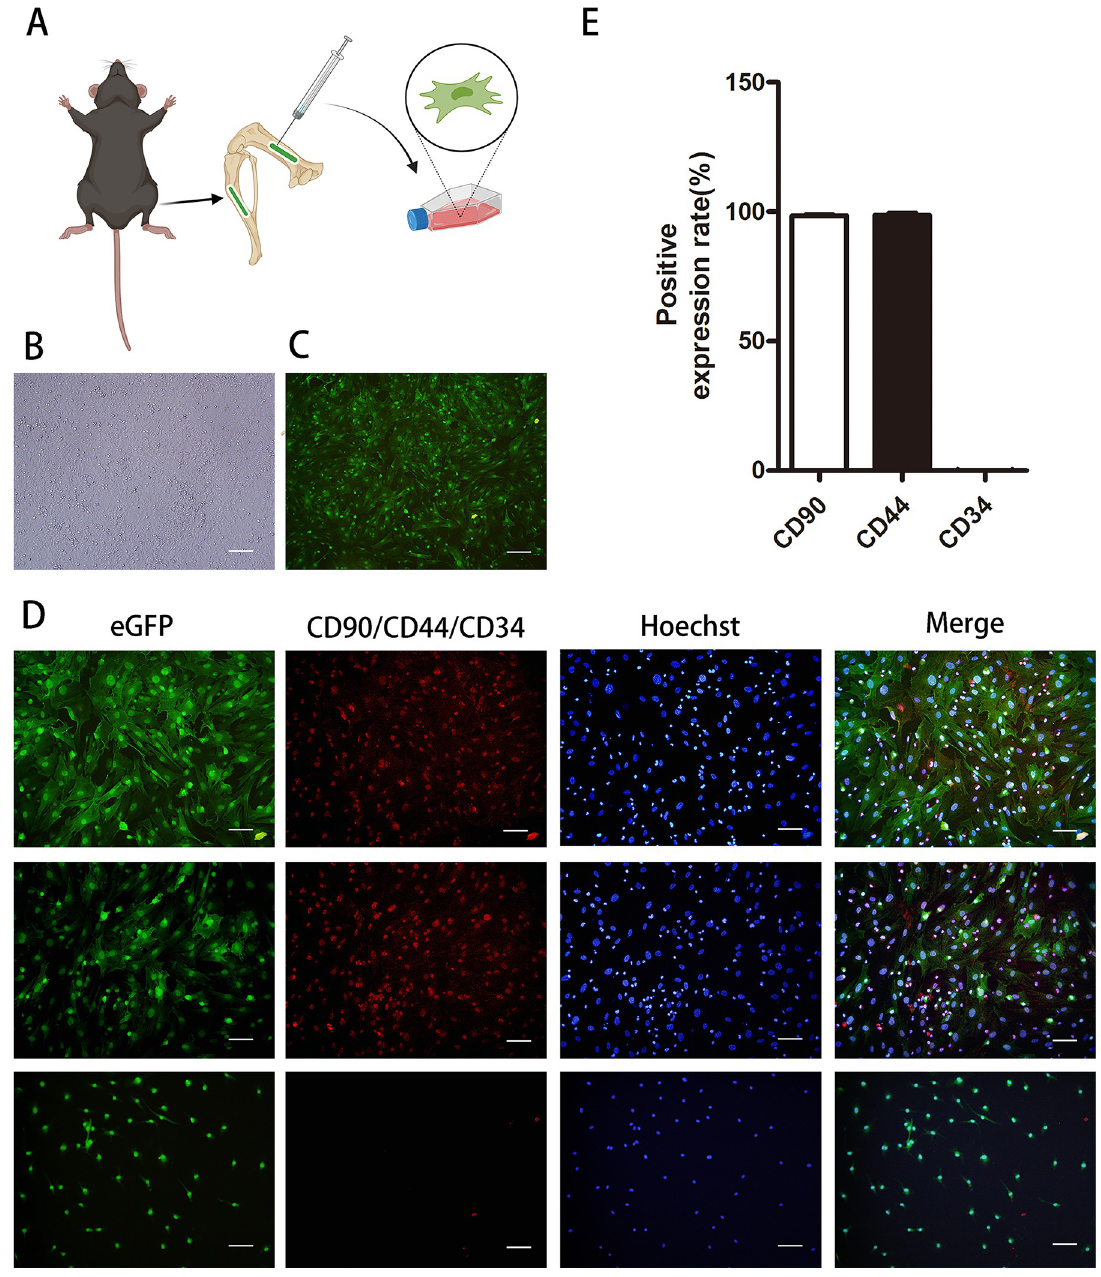
Fig 1. Extraction and identification of green fluorescent protein-labeled bone marrow mesenchymal stem cells. A Schematic diagram of cell extraction. B Cell morphology under an optical microscope (x100 magnification). Scar bar: 100 μ m. C Cell morphology under a fluorescent microscope (x100 magnification). Scar bar: 100 μ m. D The surface markers of BMSCs were identified by cellular immunofluorescence. CD90 and CD44 showed red fluorescence as antigen-positive expression; CD34 did not show red fluorescence as antigen-negative expression. Scar bar: 50 μ m. E Statistical results on the expression of surface markers CD90 , CD44 and CD34 in BMSCs. Dates are presented as mean ± SD (n = 5). increased in the miR-31 agomir group in a time-dependent manner compared with the control group ( P < 0.05, P < 0.001). However, the proliferation of BMSCs in the miR-31 antagomir group was inhibited at 72 h compared with the control group ( P < 0.001). Flow cytometry